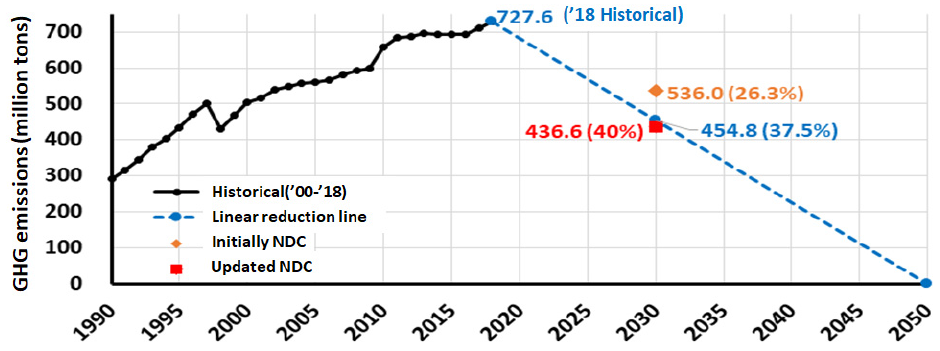
Figure 1. Historical GHG emissions, emission target of Korea, and 2050 net-zero [6]. The new NDC reflects the strong will of the government to reduce GHG